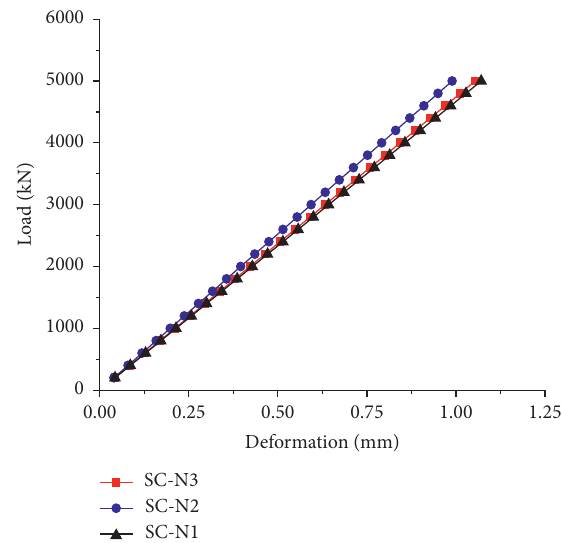
Figure 25: Load-deformation relationship of compressive specimens.